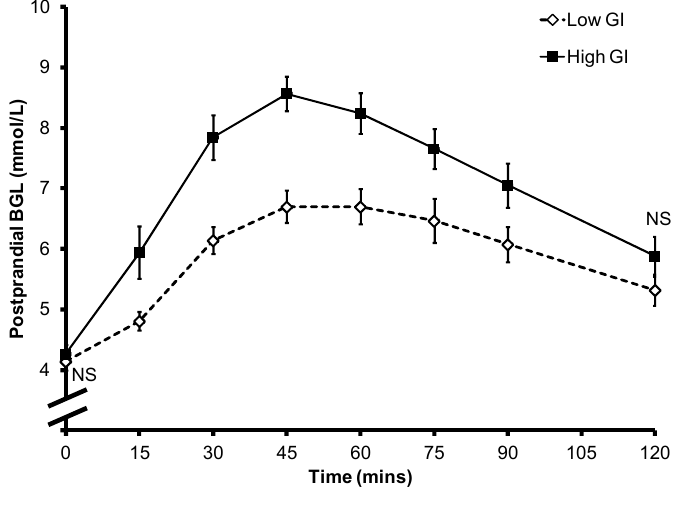
Figure 1. Mean ± SEM postprandial blood glucose level of the 10